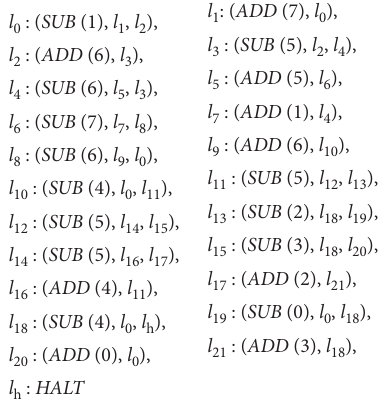
Figure 8: A universal register machine M and 23